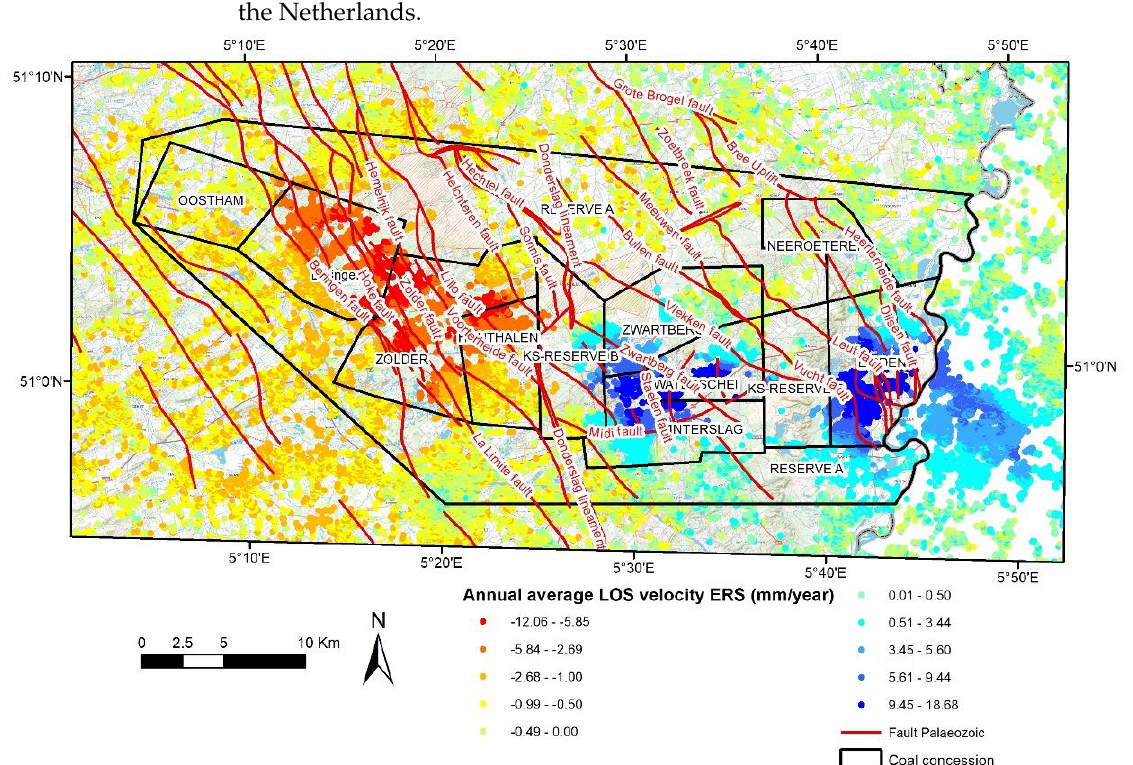
Figure 10. Relevant piezometers available in the study area and the extension of coal concessions with the year of mine closure (in red).